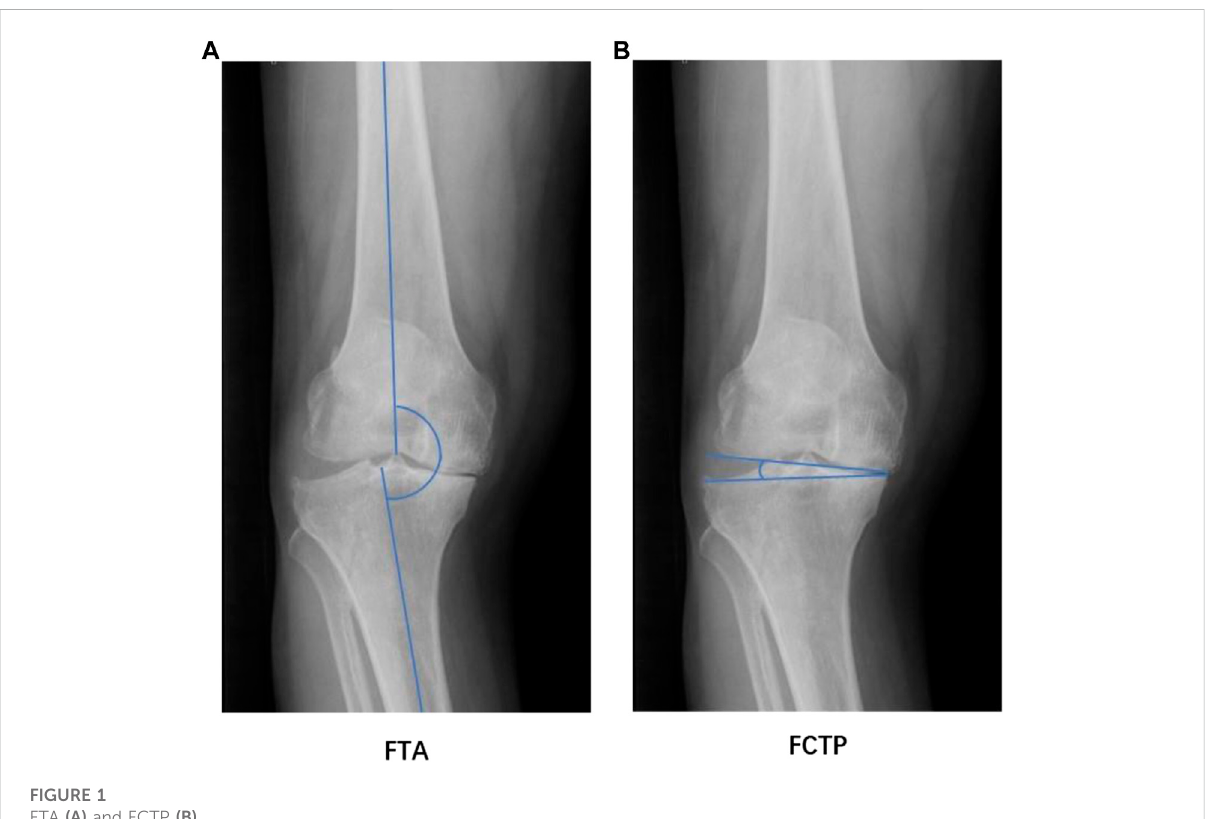
FIGURE 1 FTA (A) and FCTP (B)